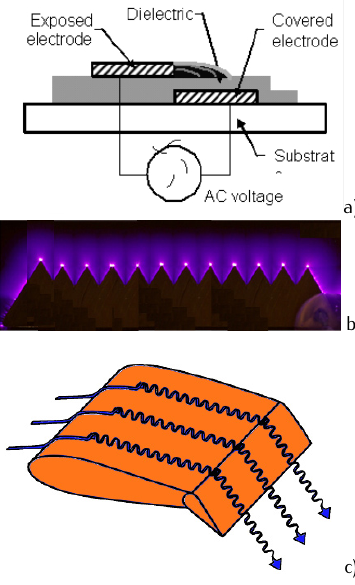
Figure 10. Boundary layer control using plasma actuator. a) Dielec- tric Barrier Discharge (DBD). b) Riblet of DBD actuators in sawtooth shape. c) Effect of the vortex generators to control boundary layer